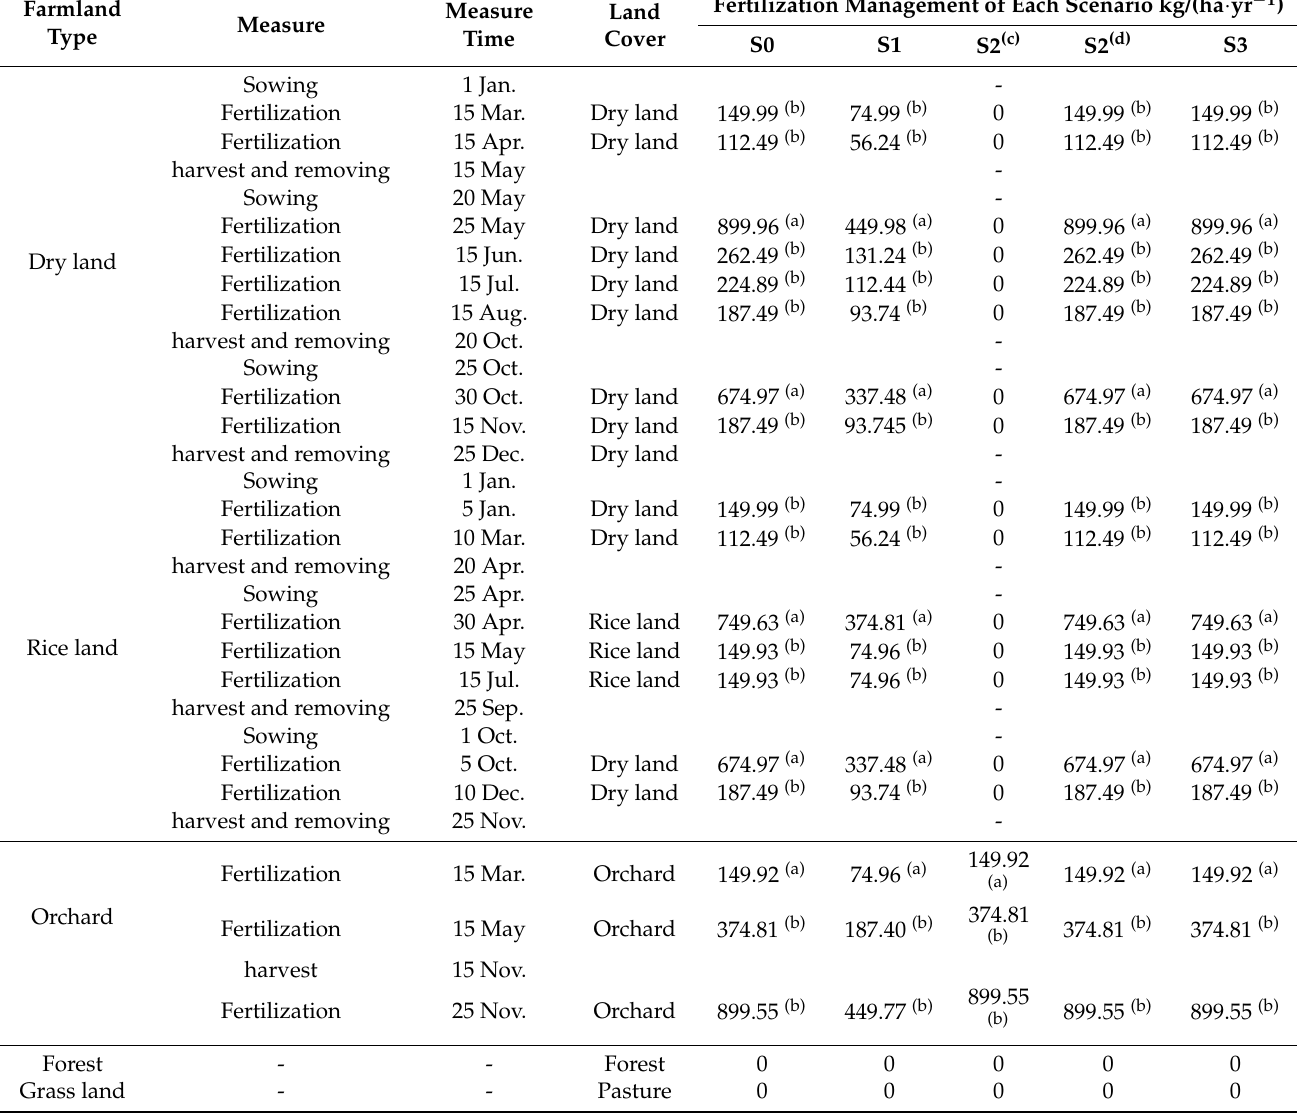
Table A2. Planting and fertilization management of each scenario in SWAT operations. S0: current situation; S1: halving fertilization every year; S2: fallow every other year; S3: returning agricultural land to